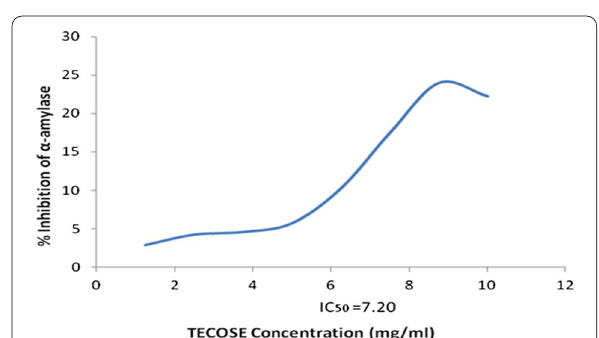
Fig. 3 Percentage inhibition of α-amylase by Tetracarpidium conophorum seed